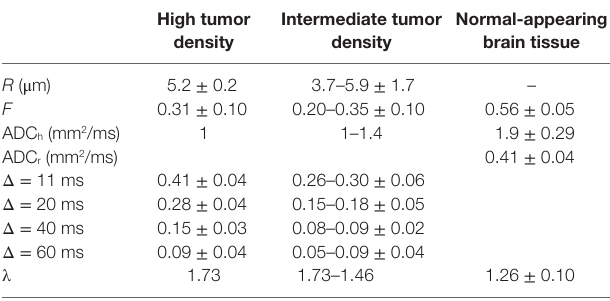
TaBle 1 | results of the biexponential modeling of restricted and hindered DW-signal (eqs 3 and 4). high tumor intermediate tumor density